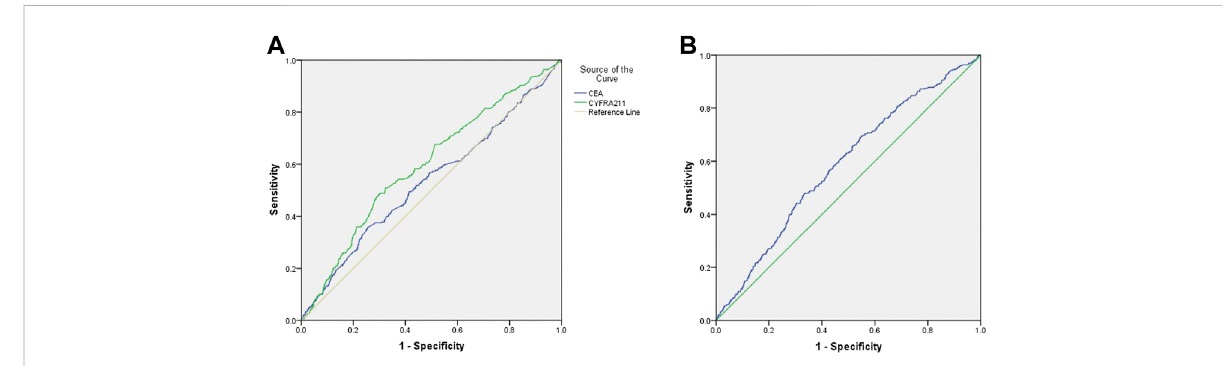
FIGURE 4 (A) ROCcurveofCEAand CYFRA21-1 levelsinlungcancer patients withmediastinallymphnode metastasis. (B) ROC curveofCEA +CYFRA 21- 1 in lung cancer patients with mediastinal lymph node